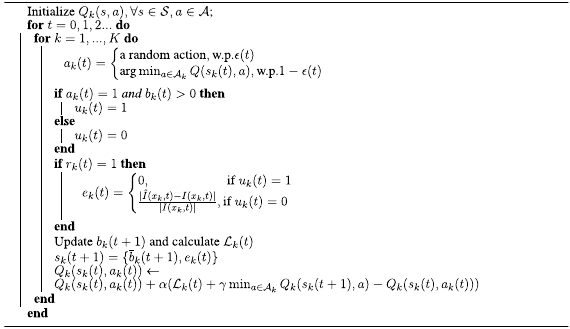
Algorithm 1. Q -learning algorithm to obtain the optimal